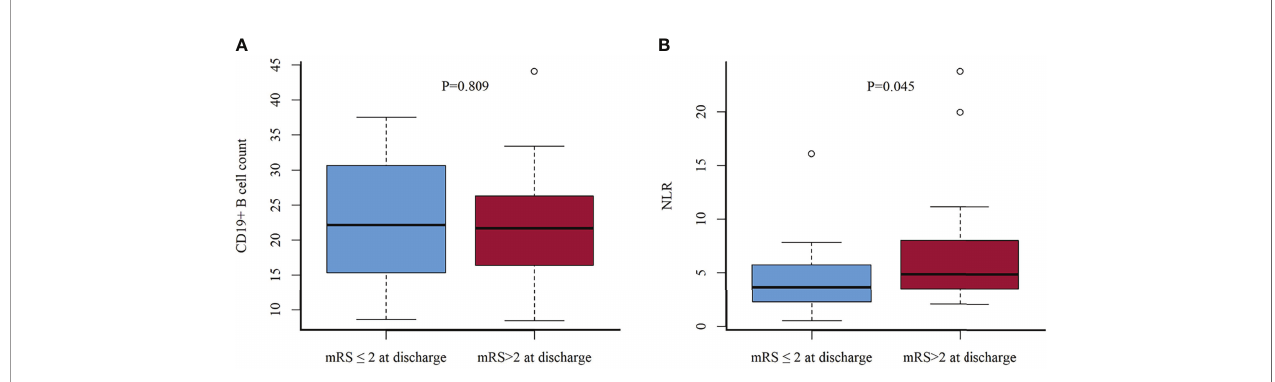
FIGURE 3 | CD19 + B-cell count (A) and NLR (B) in functional independence group (mRS scores, ≤ 2) vs. nonindependence group (mRS scores, >2) at discharge. NLR,